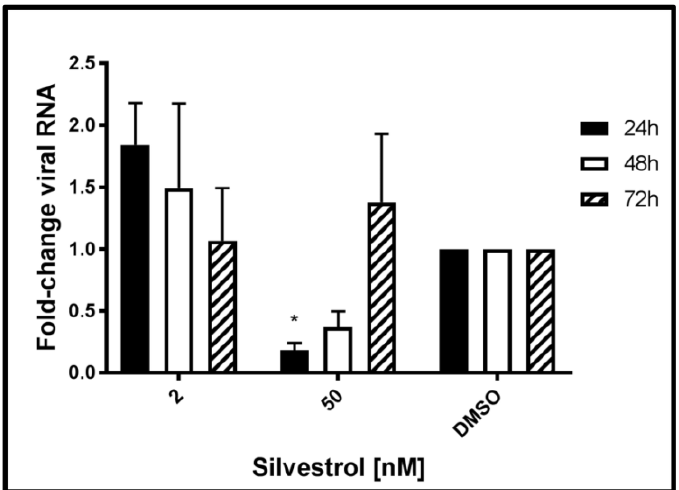
Figure 3. Effect of silvestrol on the intracellular amount of HEV-specific RNA in A549 cells persistently infected with HEV strain 47842c. qPCR analysis using ORF2-specific primers of total RNA isolated from A549 cells persistently infected with HEV; data were normalized to intracellular RPL27 RNA levels. Cells were treated with 2 nM or 50 nM silvestrol, DMSO treatment served as control. n = 3; * p < 0.05.